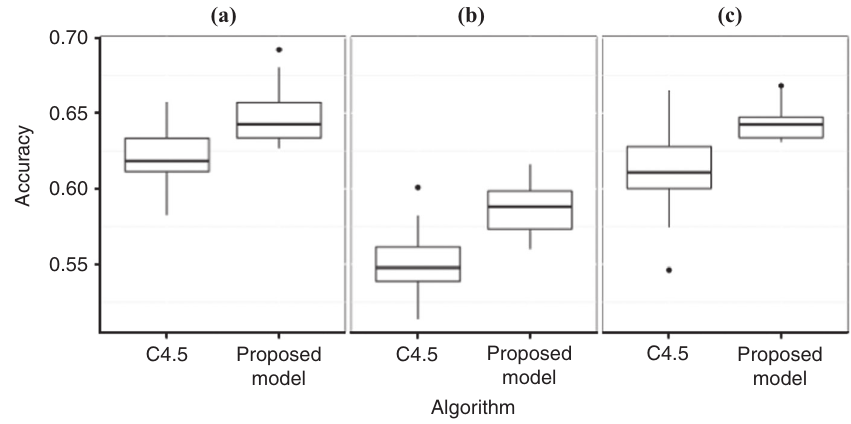
Figure 1. A comparison of the accuracy rate between the standard C4.5 classifier and the proposed model in the data